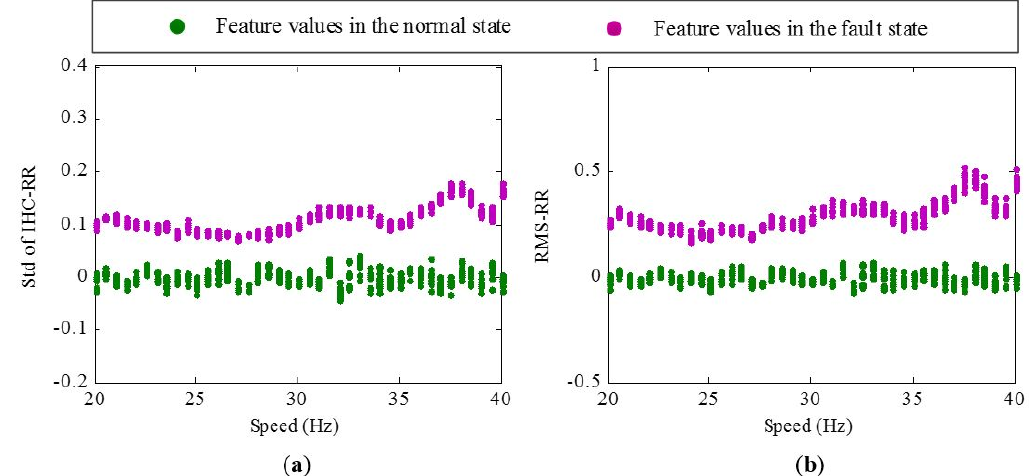
Figure 6. Results of the extracted RR features: ( a ) Std of IHC-RR; ( b ) RMS-RR.